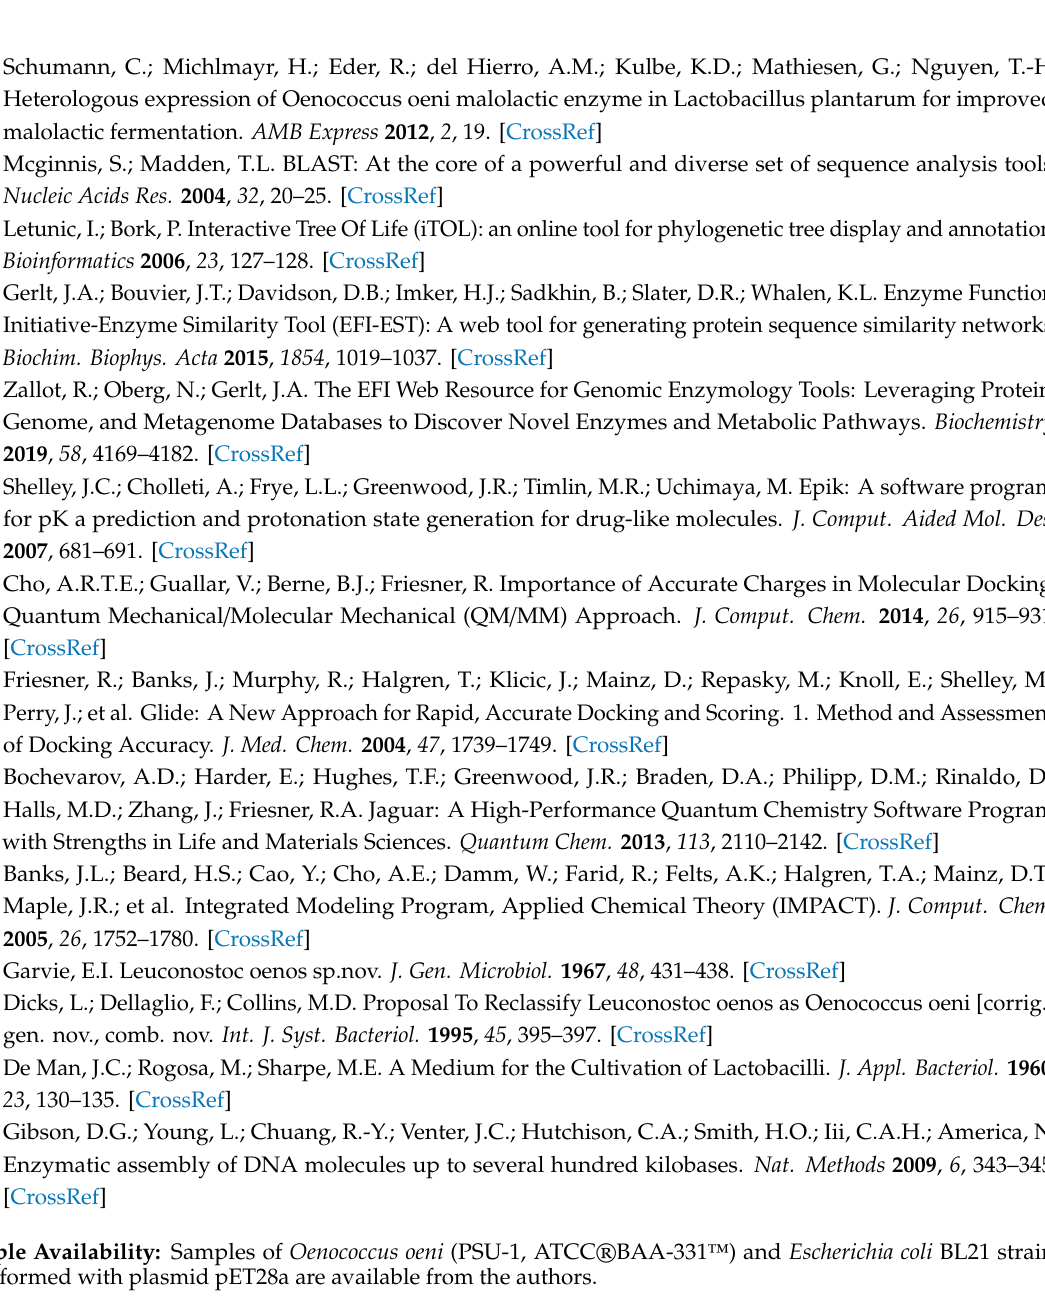
Sample Availability: Samples of Oenococcus oeni (PSU-1, ATCC ® BAA-331 ™ ) and Escherichia coli BL21 strain transformed with plasmid pET28a are available from the